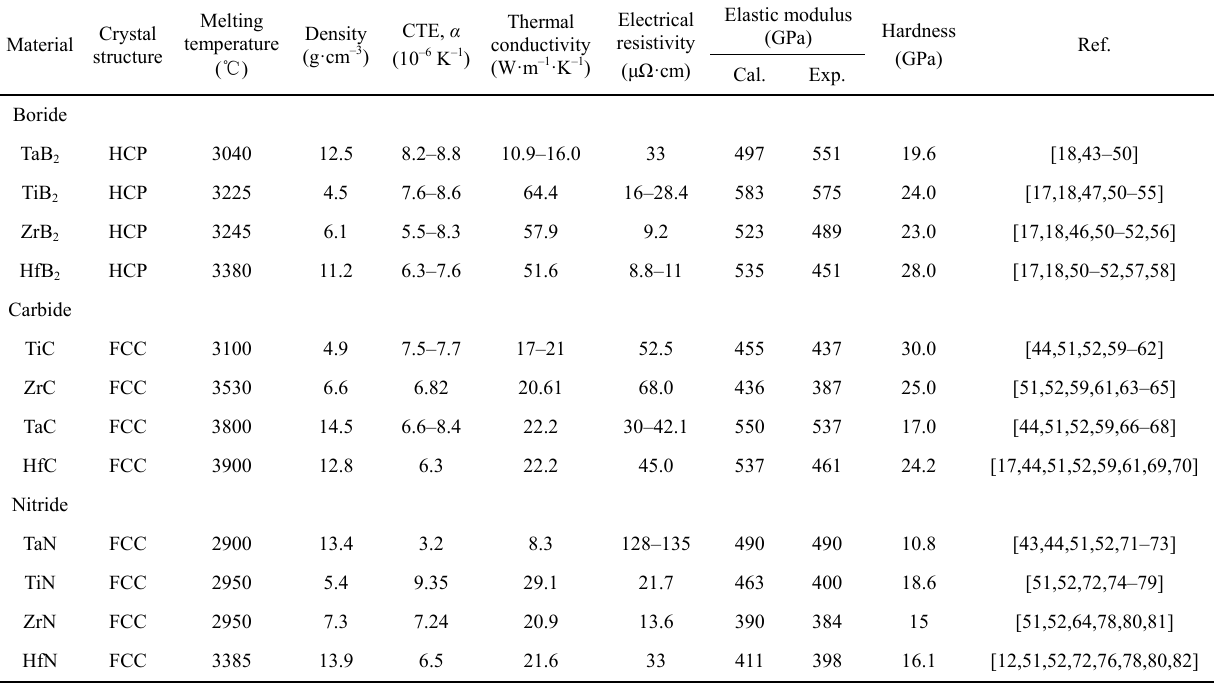
Table 1 Basic physical and mechanical properties of boride , carbide , and nitride-based